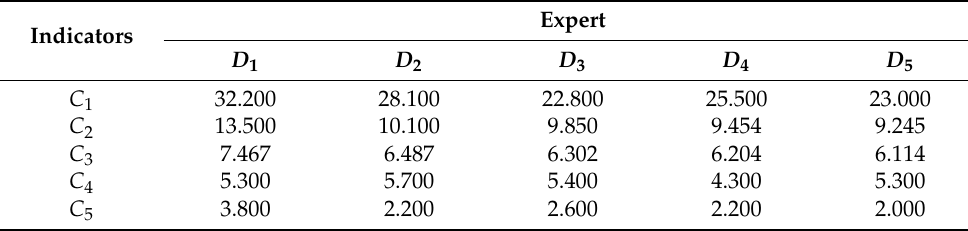
Table 5. The expert-deviation degree of the first-class index.